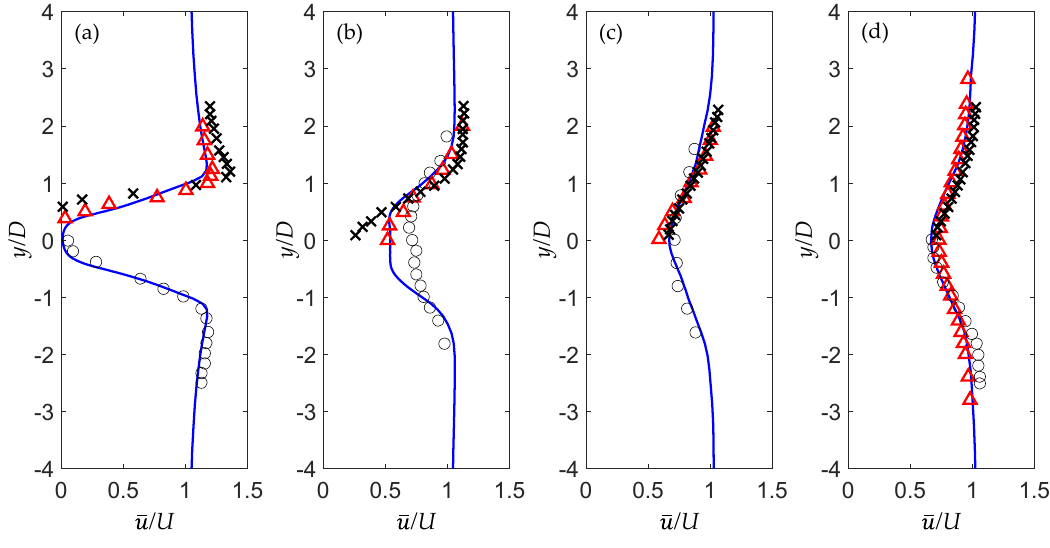
Figure 3. Comparison of the time-averaged streamwise velocity profiles at different downstream locations for a square cylinder in crossflow ( α = 0°). ( a ) − : present study, x = 1 D ; : Lyn et al. [15], x